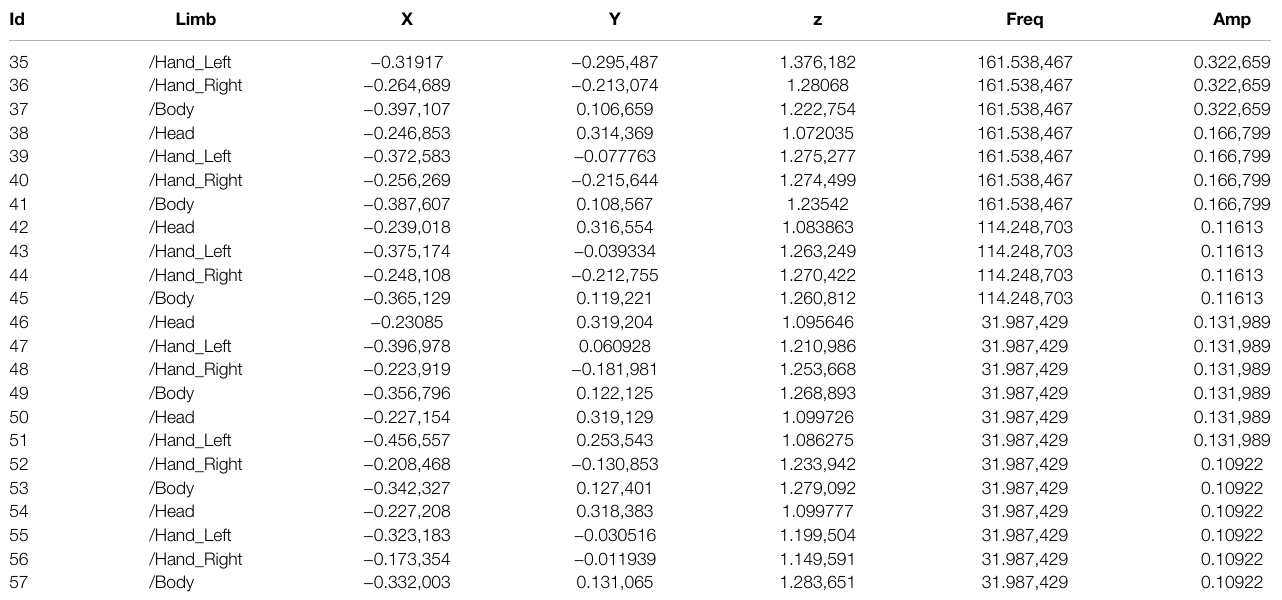
TABLE 1 | Example of the Creative AI